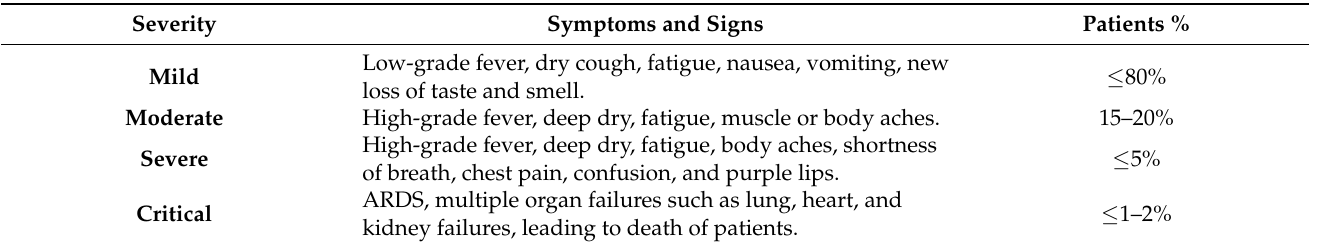
Table 1. Characteristics of clinical manifestations in COVID-19